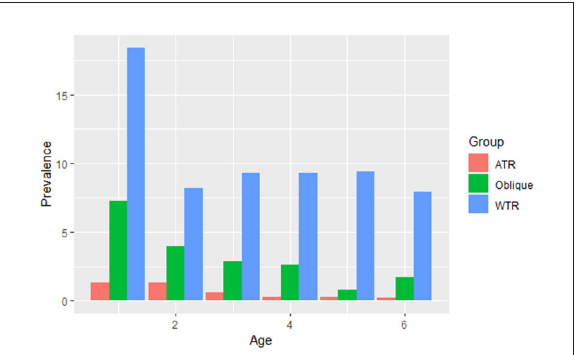
FIGURE4 The prevalence of different types of astigmatism among the different age groups. WTR: with the rule ( + cylinder axis 90 ◦ ± 15 ◦ ); ATR: against the rule ( + cylinder axis 180 ◦ ± 15 ◦ ); all other orientations were considered oblique